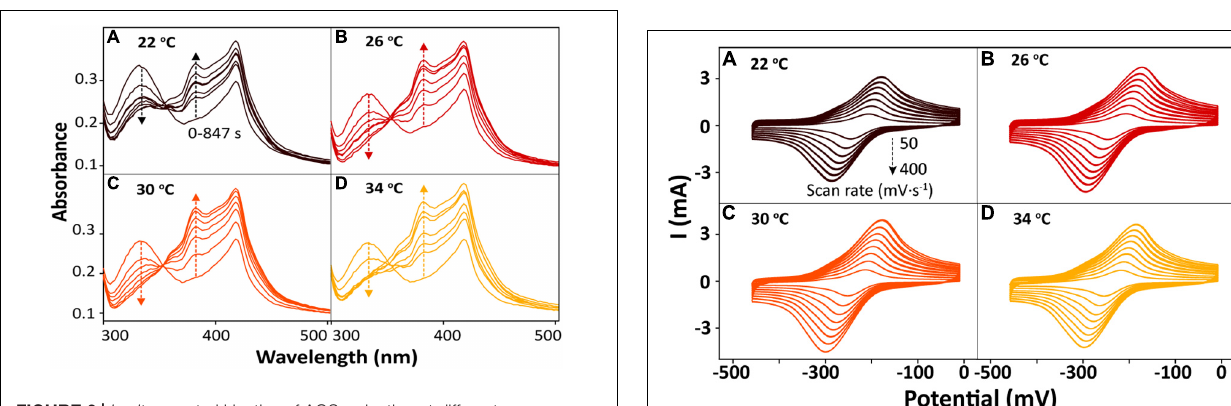
FIGURE 6 | In situ spectral kinetics of AQS reduction at different temperatures: (A) 22 ◦ C, (B) 26 ◦ C, (C) 30 ◦ C, and (D) 34 ◦ C. The concentrations of AH 2 QS were calculated from the absorbance peak at 382 nm. Test conditions: 50 µ M AQS with MR-1 (OD 600 = 1.0) and 50 mM lactate.